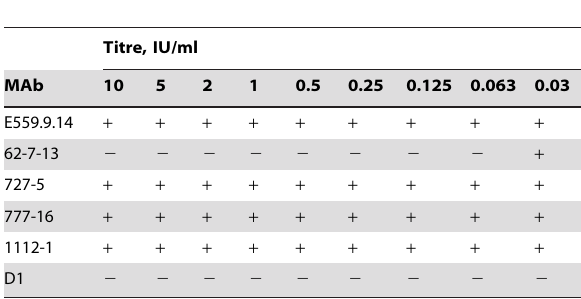
Table 2. Neutralization pattern of candidate MoMAbs (E559.9.14, 62-7-13, 727-5, 777-16) or other MoMAbs